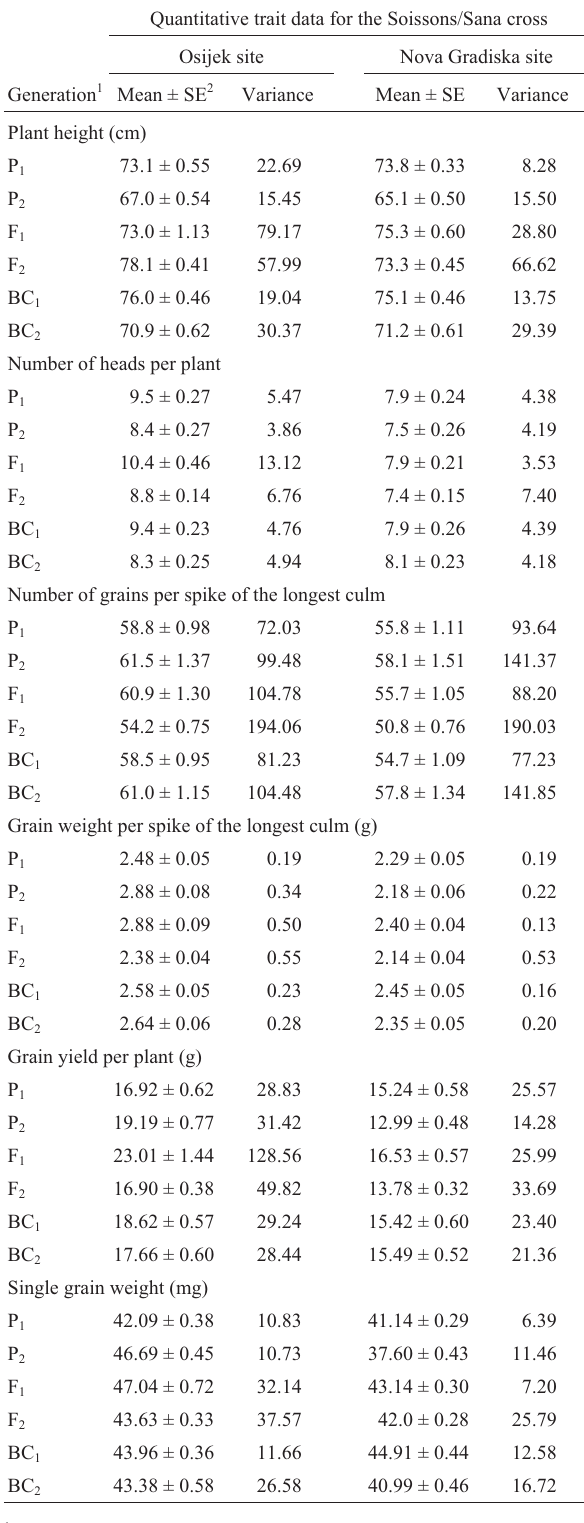
Table 2 - Quantitative trait data for the Soissons/Sana cross at the Osijek and Nova Gradiska sites. Quantitative trait data for the Soissons/Sana